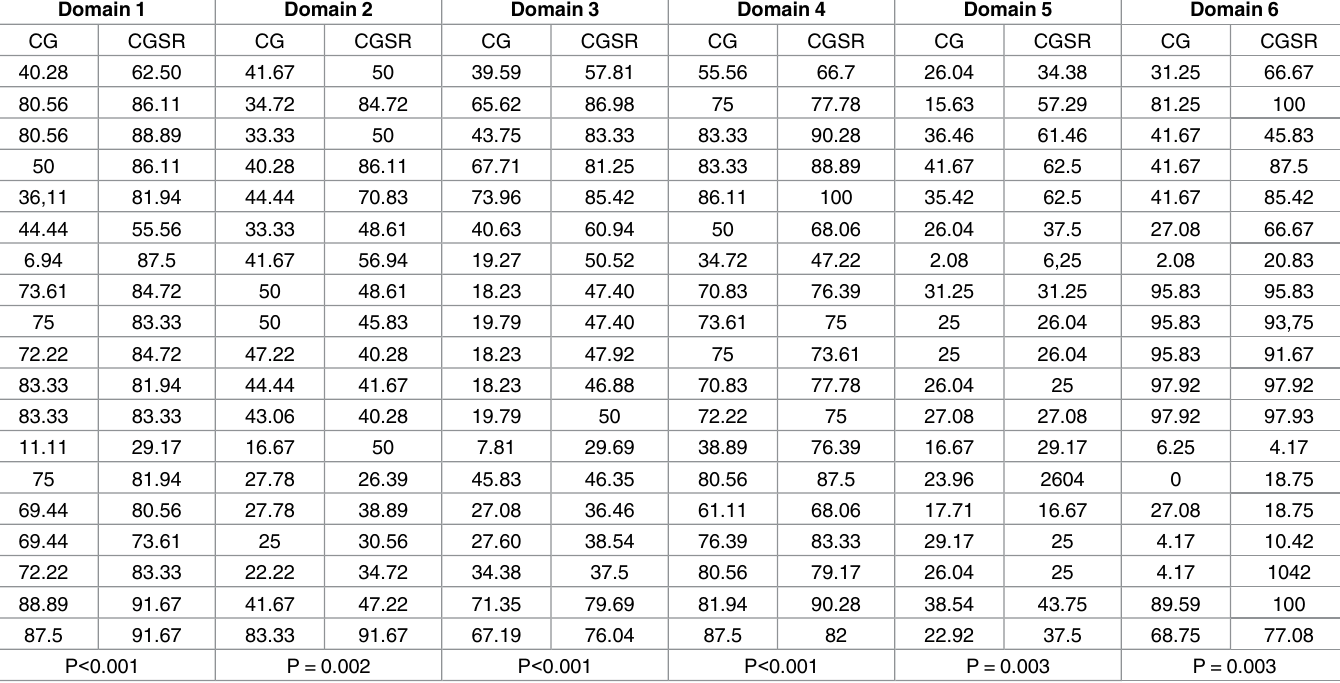
Table 3. Comparison of AGREE II scores (percentage of the maximum possible score for a specific domain) between consensus guidelines alone and consensus guidelines + systematicreviews. CG: consensus guideline;CGSR: consensusguideline+ systematic review). Scores are related to 19 possiblecomparisons. The p values refer to Wilcoxon SignedRank Test for